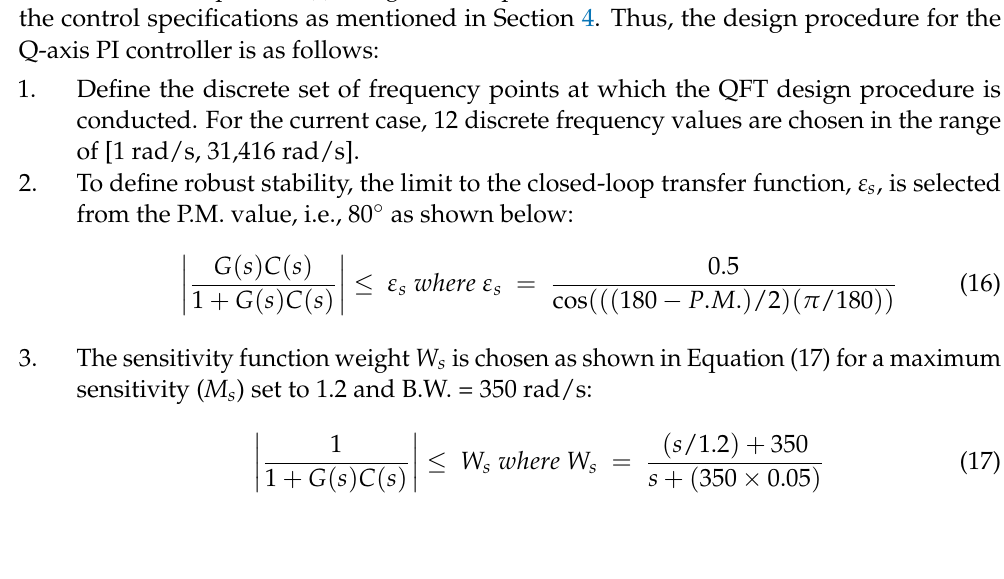
Figure 7. Stable PI values to initialize the FPA search space.